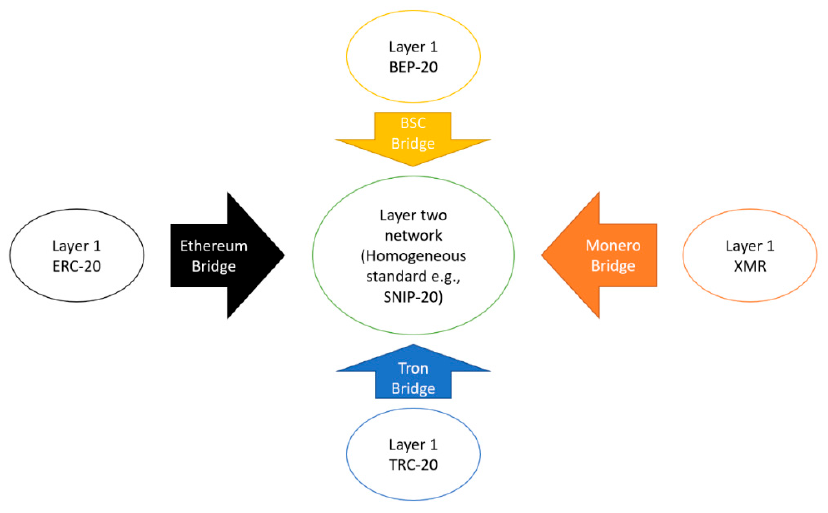
Figure 6. Interoperable two-layer networks (e.g., Secret Network,